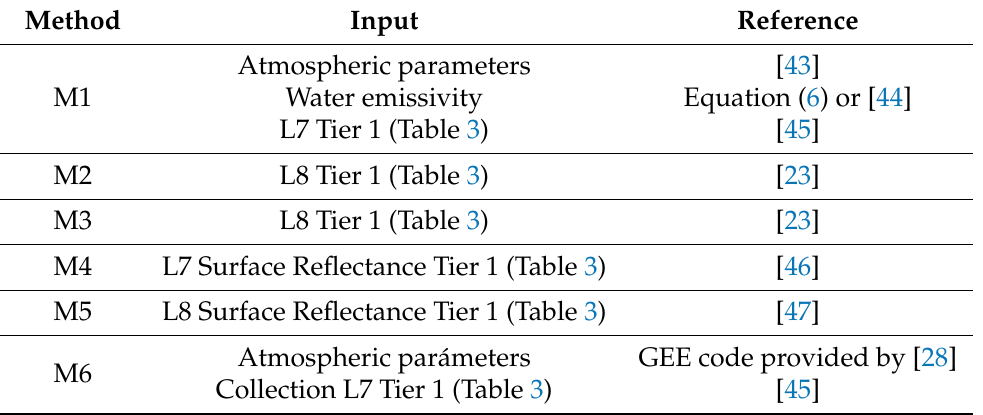
Table 4. Required input of six methods (M1 to